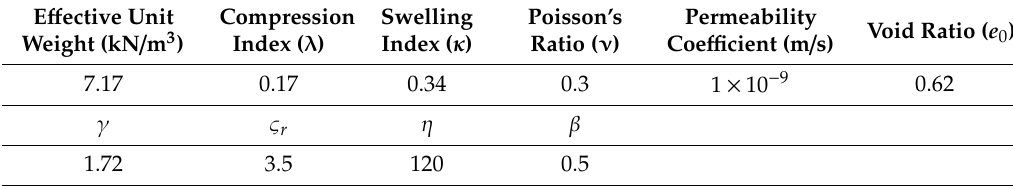
Table 1. Properties of seabed adopted in the case